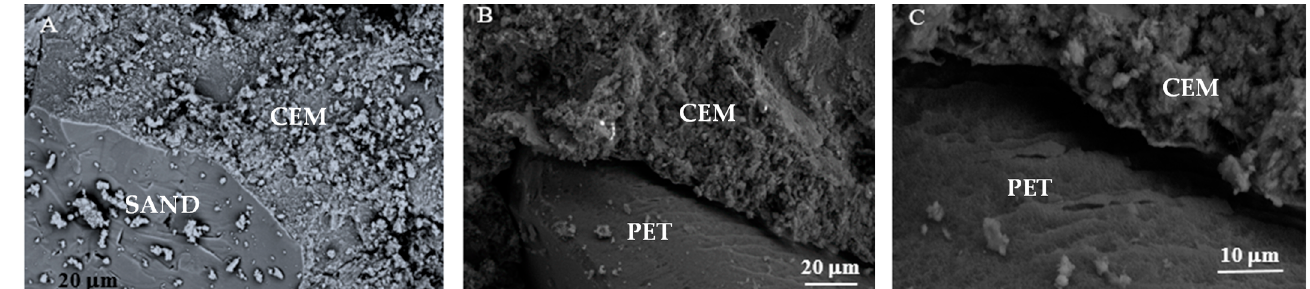
Figure 7. Scanning electron microscope detections of: ( A ) sand/cement interface in the SAND2 composite, ( B ) PET/cement interface in the PET2 composite, ( C ) magnification of the PET/cement interface from ( B ).